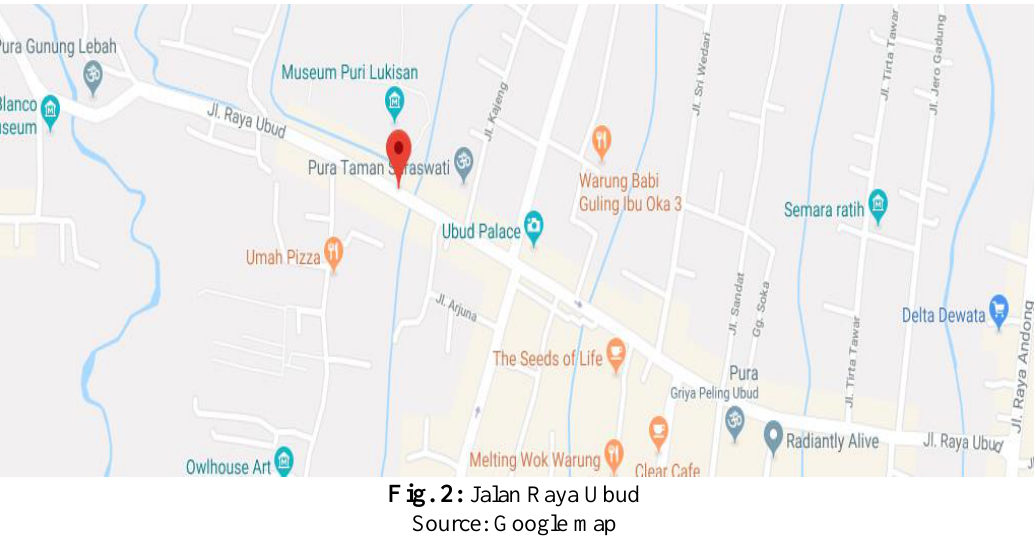
Fig. 2: Jalan Raya Ubud Source: Google